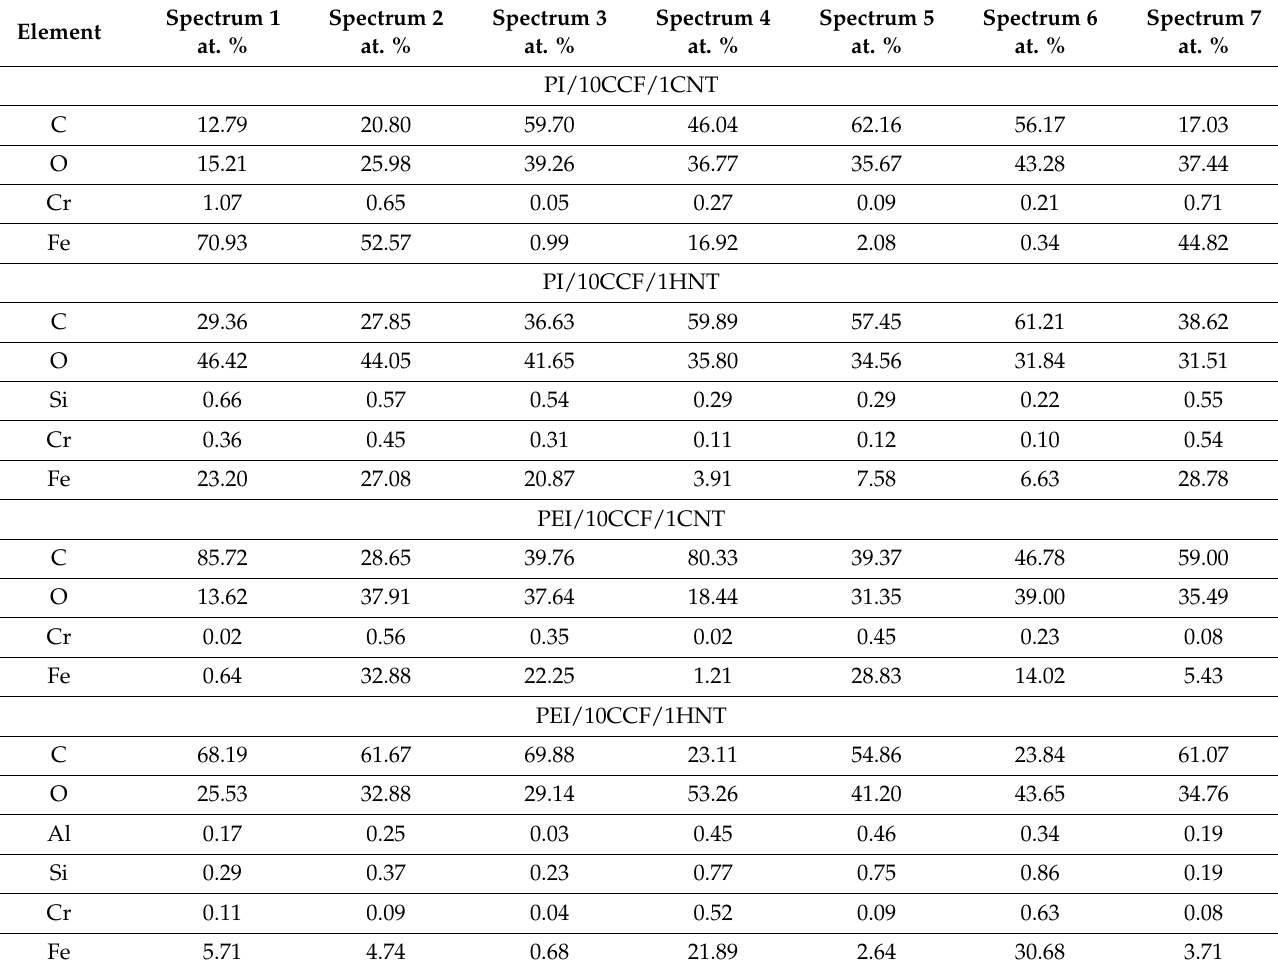
Table 6. The results of EDS analysis on the wear track surfaces shown in Figure